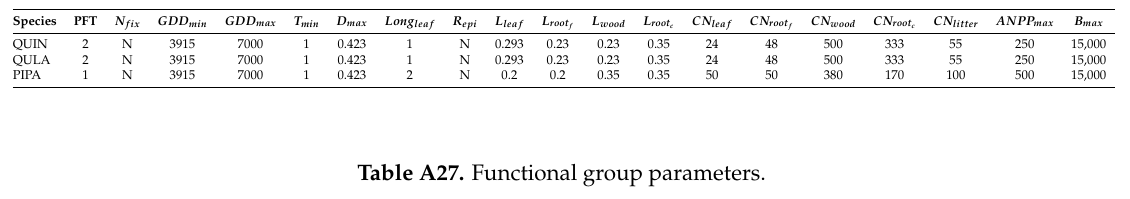
Table A26. NECN species parameters.